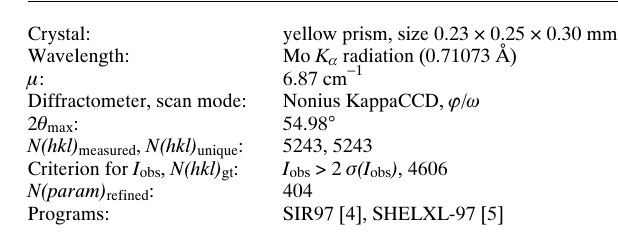
Table 1. Datacollection and handling.